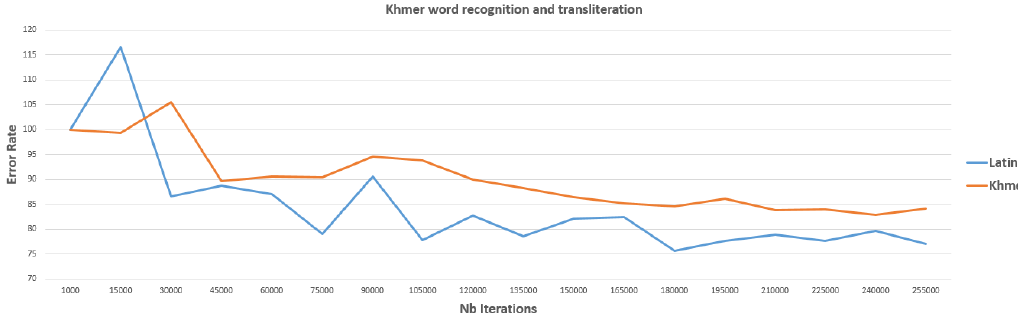
Figure 27. Error rate for Khmer word recognition and transliteration test set.